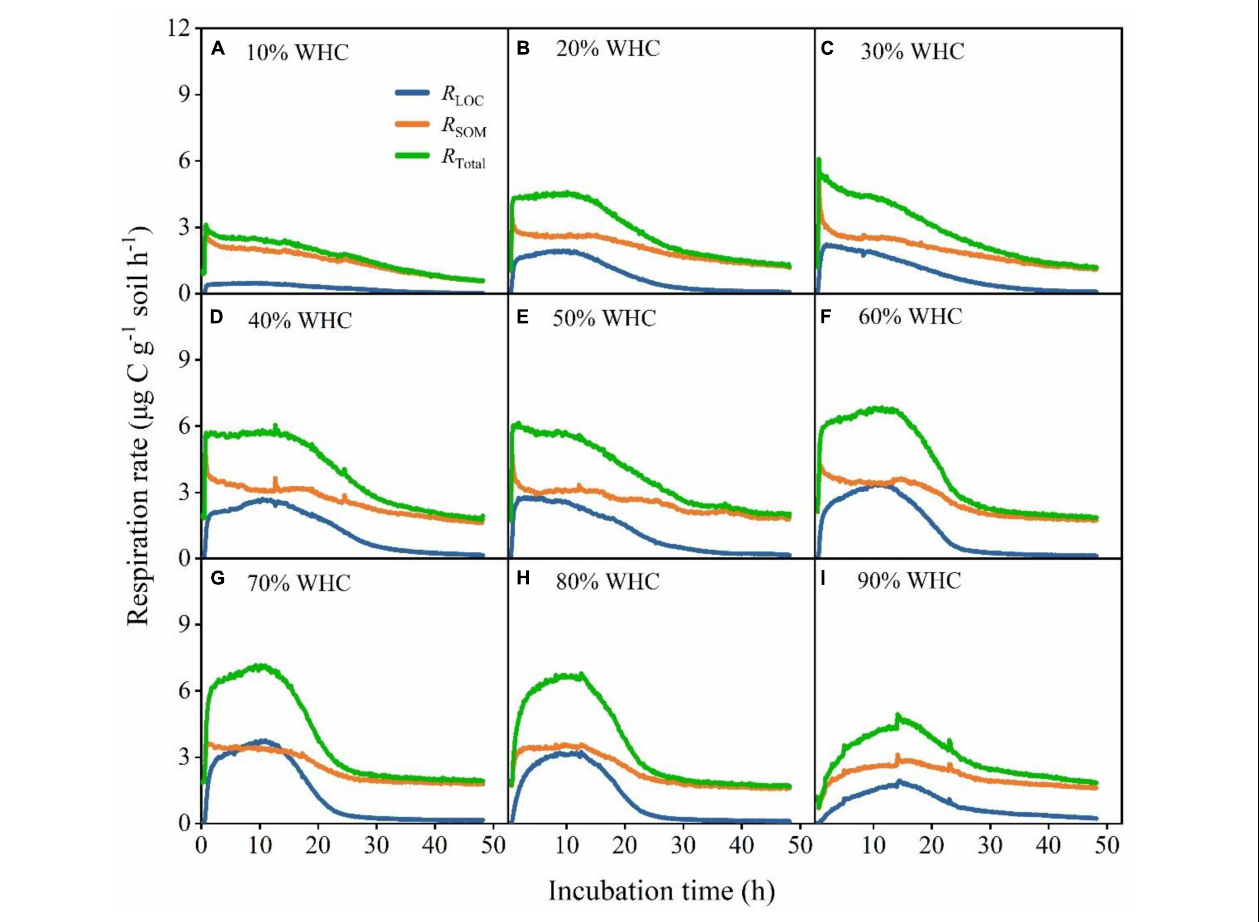
FIGURE 2 | Changes in soil microbial respiration rates under different soil moisture treatments after LOC addition. (A–I) Soil microbial respiration rates from glucose ( R LOC ), soil organic matter ( R SOM ), and the total respiration rate ( R Total ) under different temperature treatments and WHCs.